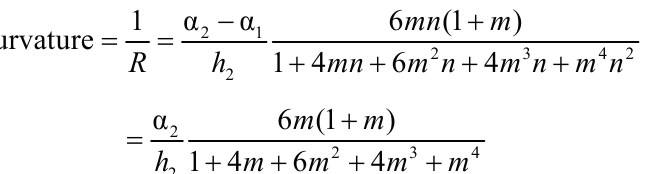
Figure 3. Illustration of Timoshenko ʼ s bimetal model in the case of ( a ) bending away from UV light and ( b ) bending toward UV light.